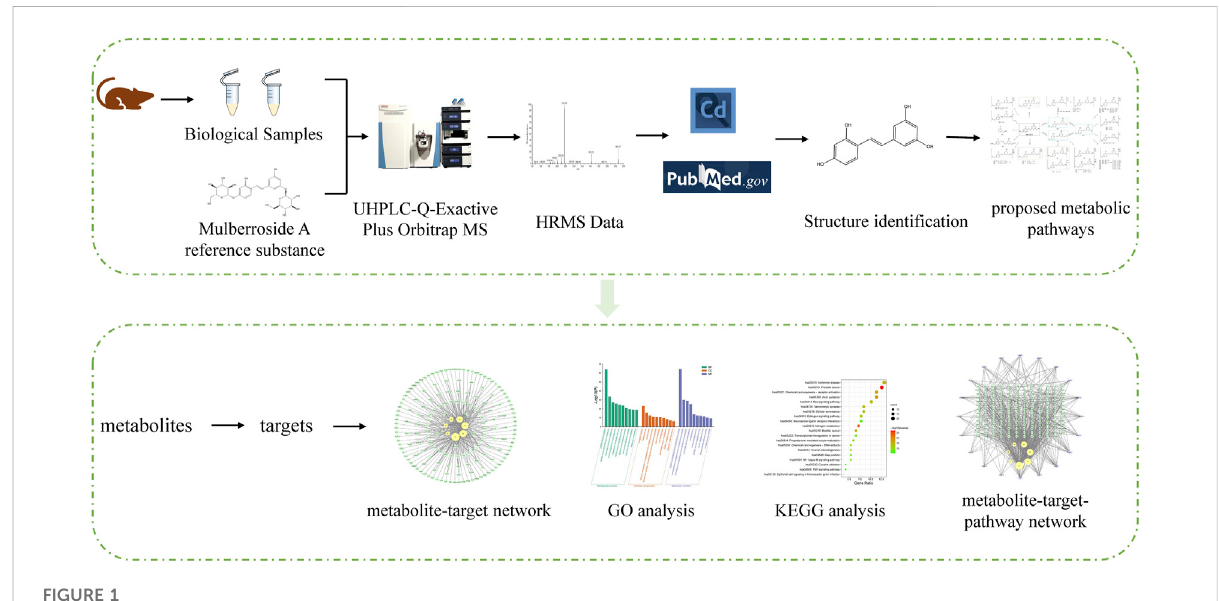
FIGURE 1 Summary diagram of the established analytical